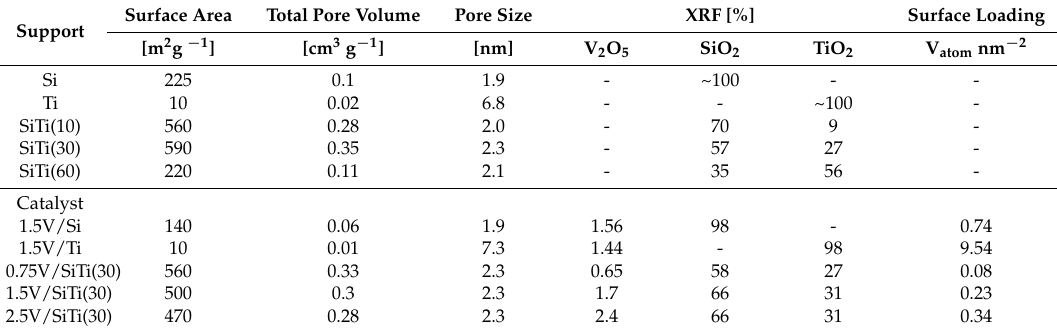
Table 1. The Brunauer-Emmett–Teller Barret-Joyner-Halenda (BET-BJH) method and X-ray fluorescence spectroscopy (XRF) results calculated as oxides for the supports and vanadium-containing catalysts.